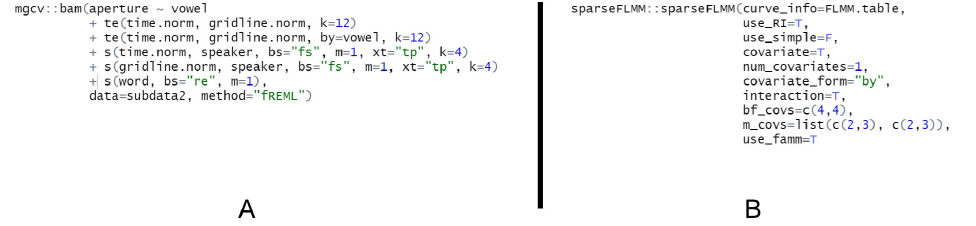
Figure 2. ( A ) R code to create the GAMMs. ( B ) R code to create the